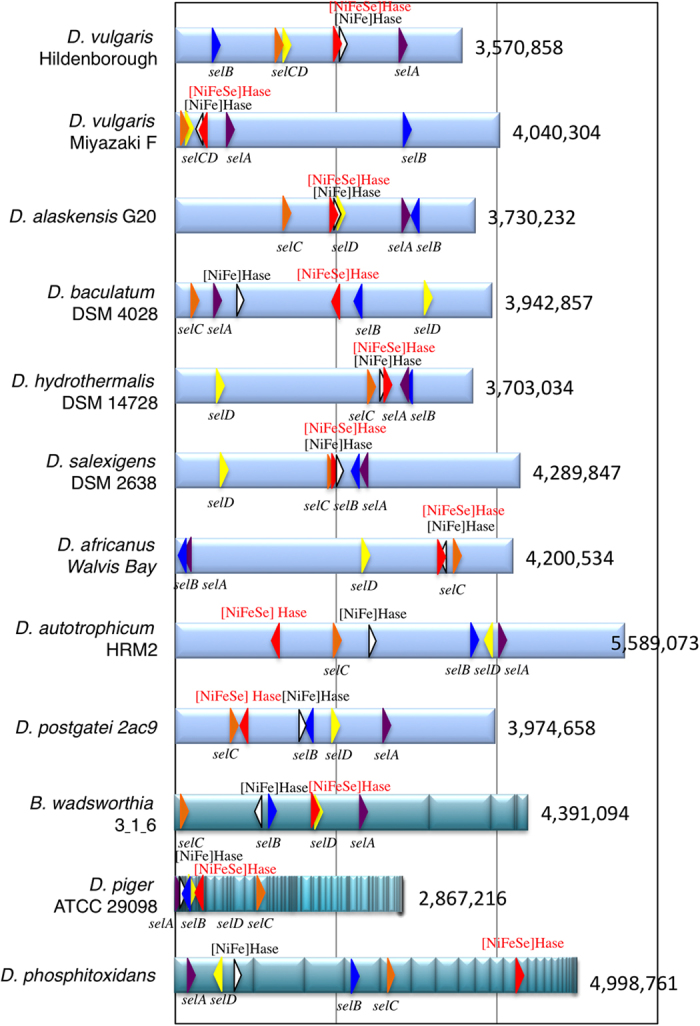
Physical genome maps.Location and coding directions are indicated by colored triangles representing selA (purple), selB (blue), selC (orange), selD (yellow), [NiFeSe] Hase (red) and [NiFe] Hase (white). Genomes of B. wadsworthia 3_1_6, D. piger and D. phosphitoxidans are draft sequences in which contigs are interrupted by gaps that remain to be elucidated for the completed genome sequencing.